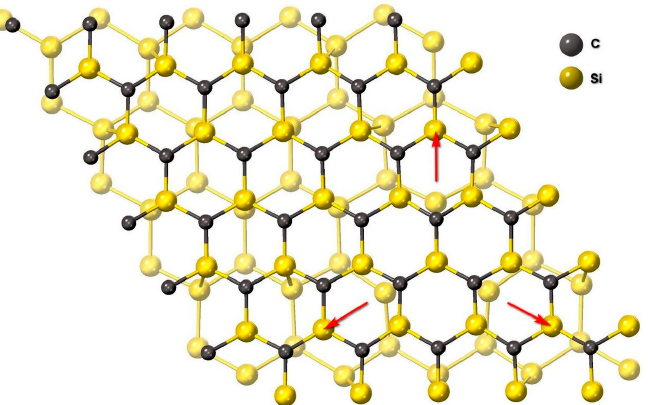
Figure 8. View of the optimal dislocation-free interface 3C-SiC (111)/Si (111) perpendicular to the interface. Arrows show Si atoms at the SiC interface, which do not form bonds with Si atoms of the substrate.